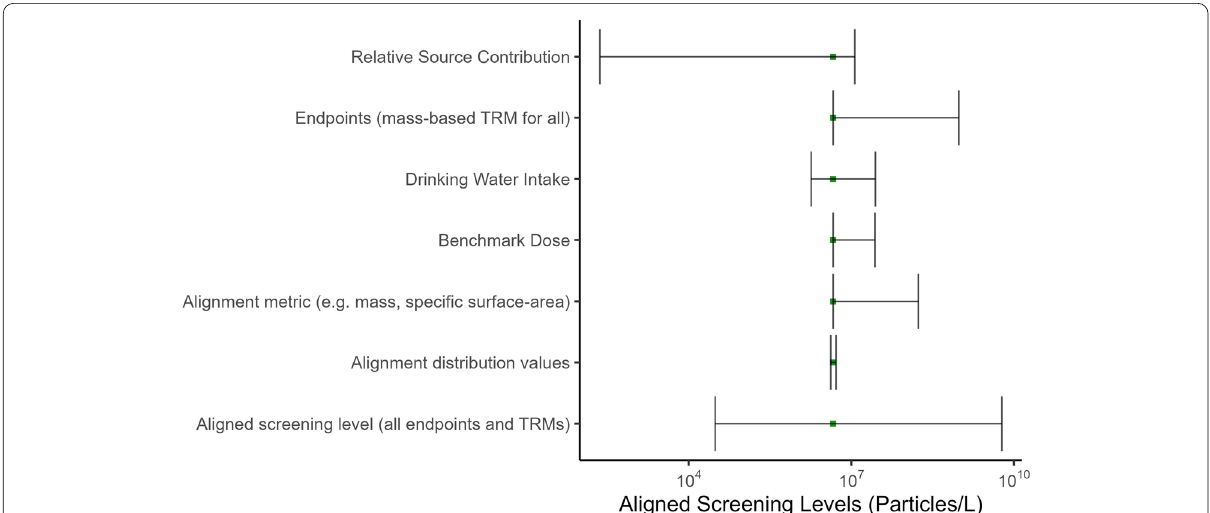
Fig. 5 Sensitivity analysis of screening level (aligned to various TRMs to a default size range of 1 to 5000 µm based on one-at-a-time analysis for each variable. For each variable, all other variables were held at their default values, and the minimum and maximum values were used to calculate the resulting lower and upper range for the screening level. The aligned screening level based on endpoint considers all TRMs aligned for all PODs from all reliable endpoints. Green squares represent the screening level obtained using the default value for that parameter, and error bars represent minimum and maximum values of the sensitivity analysis for the